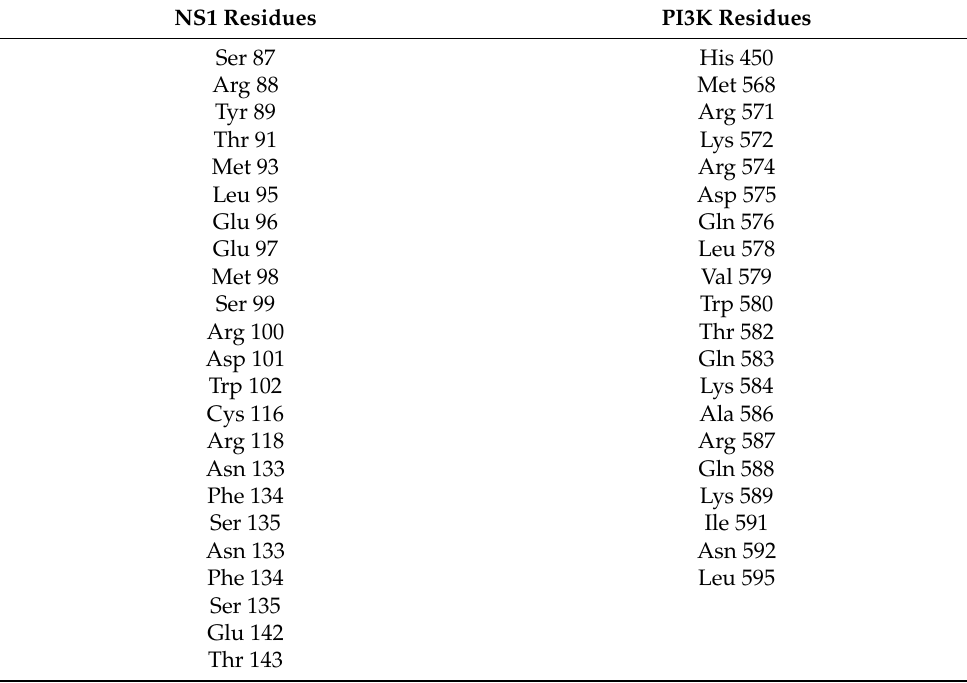
Figure 7. C α atoms RMSD calculated over the MD trajectories for the complex between NS1 and the coiled-coil domain of human TRIM25. Table 1. Amino acid residues constituting the interfacial region in the NS1-PI3K complex. NS1